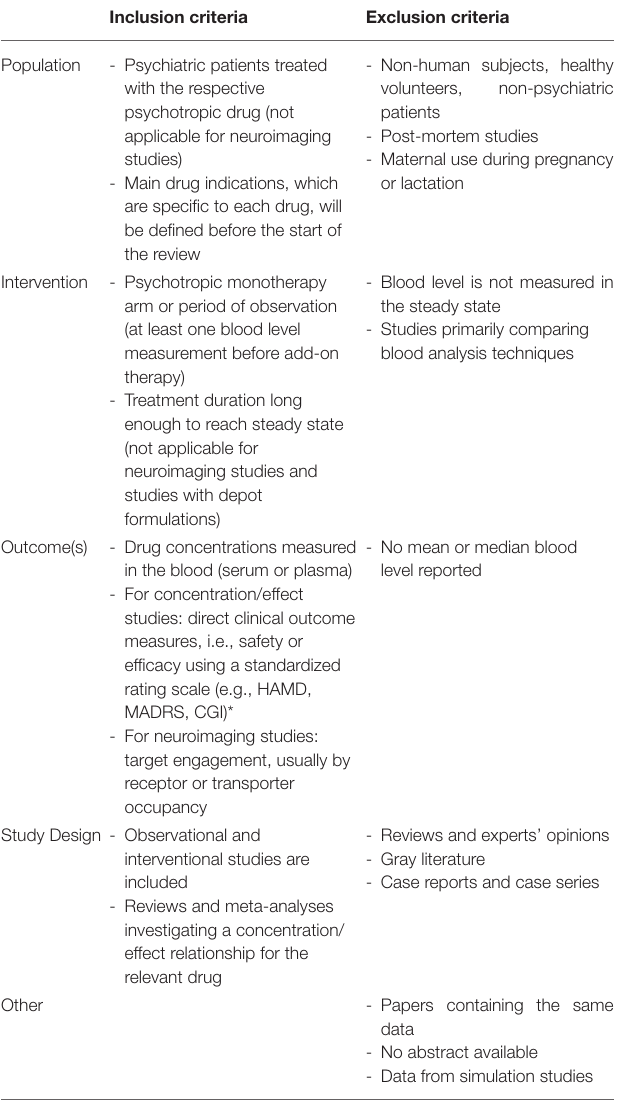
TABLE 1 | Inclusion and exclusion criteria for study